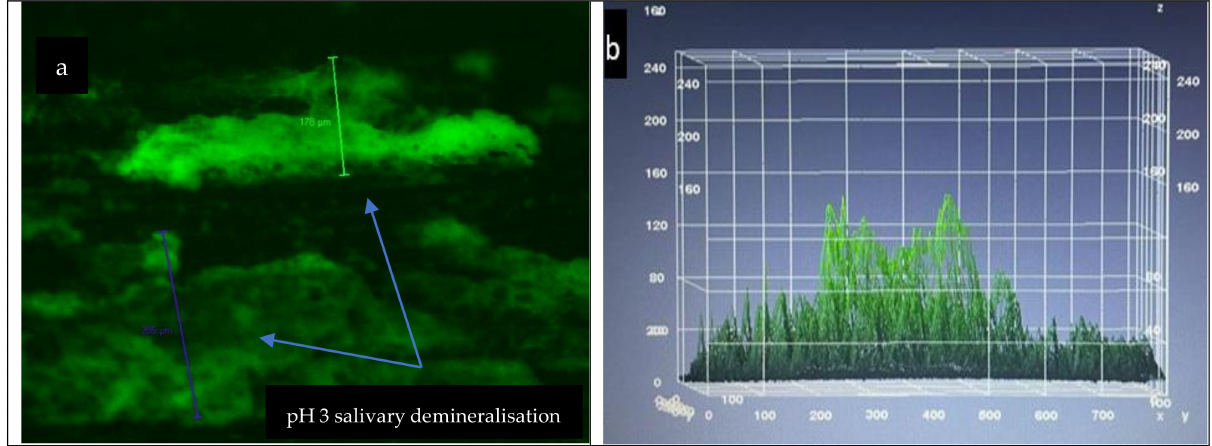
Figure 6. ( a ) pH 3 salivary demineralisation; ( b ) box plot of laser